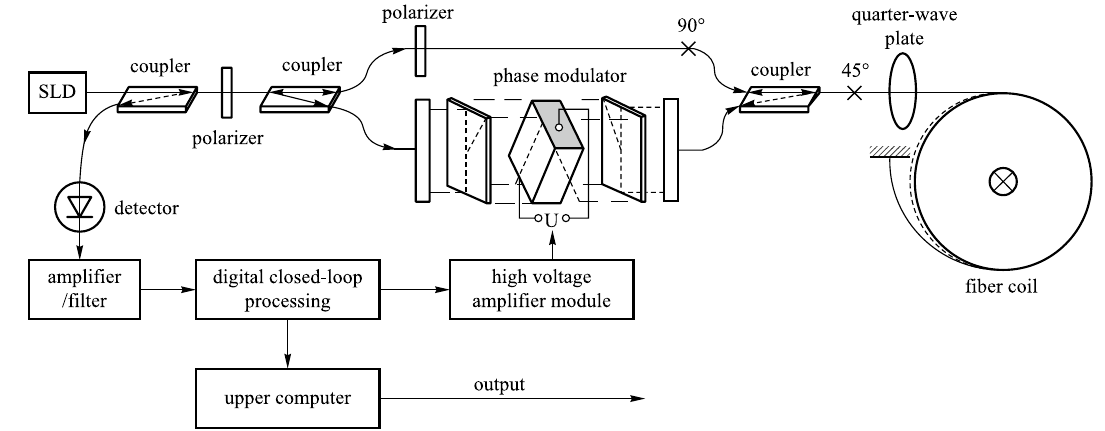
Fig. 18 FOCT based on the spatial phase modulation method [94]. Copyright 2020, Qi Y. Reprinted with